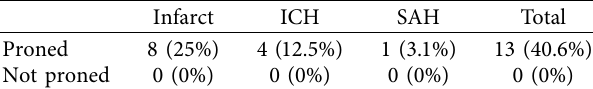
Table 4: Stroke rate in proned vs not proned.